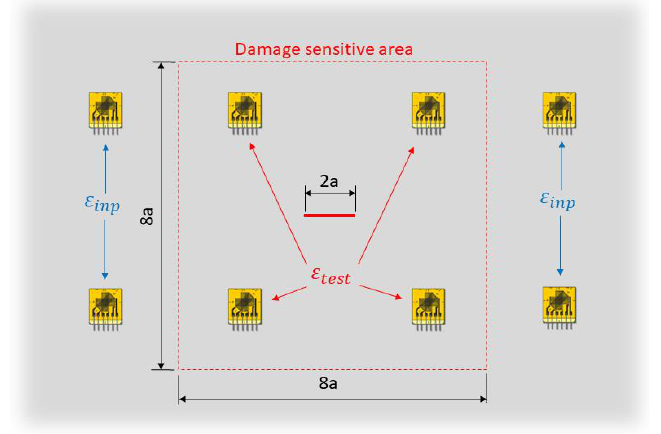
Figure 4. Portion of the shell structure with input and test sensor networks